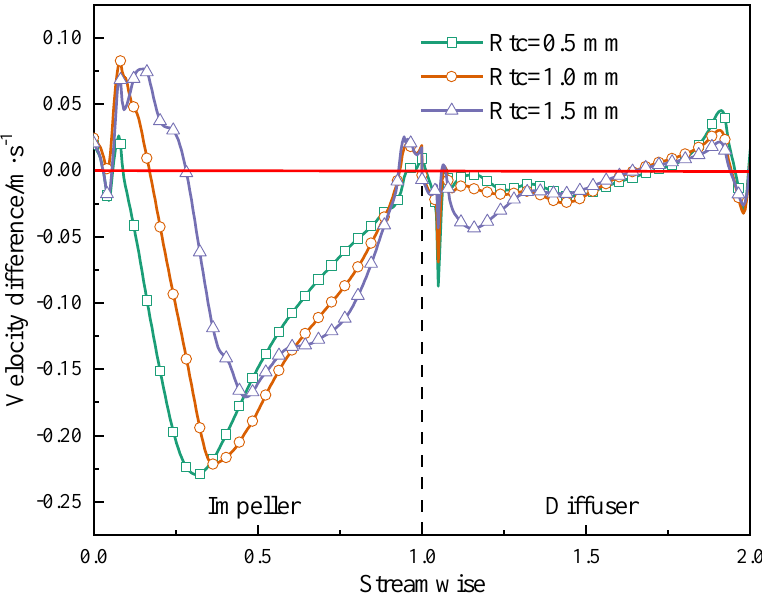
Figure 15. Gas-liquid velocity difference in impeller and diffuser along streamwise.